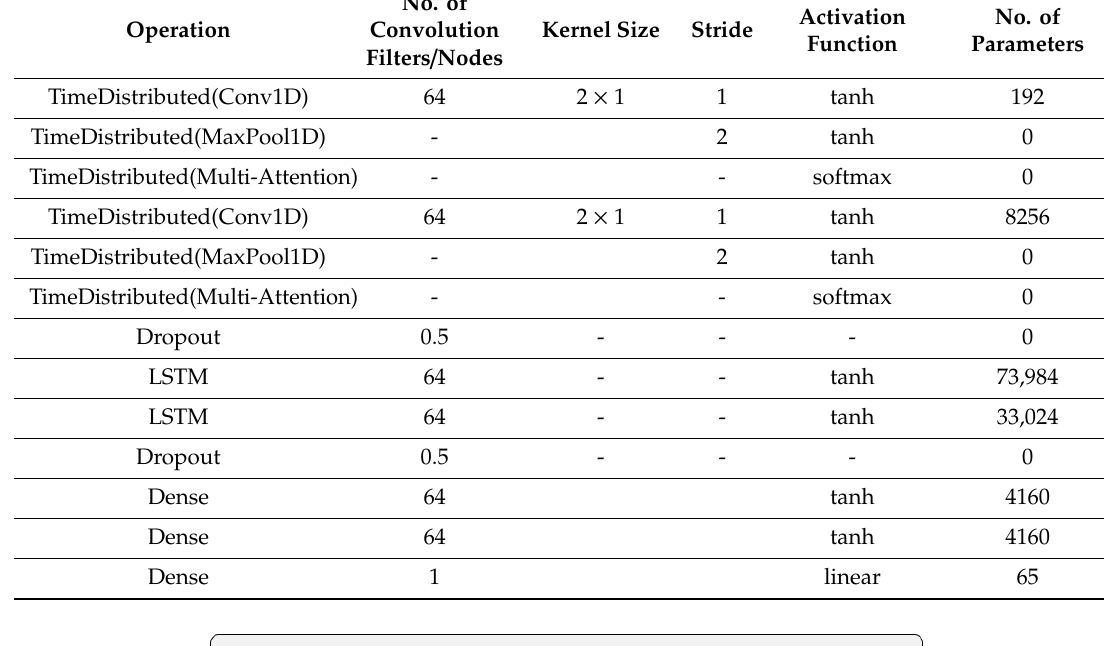
Table 3. Summary of the hyperparameters of the proposed model.